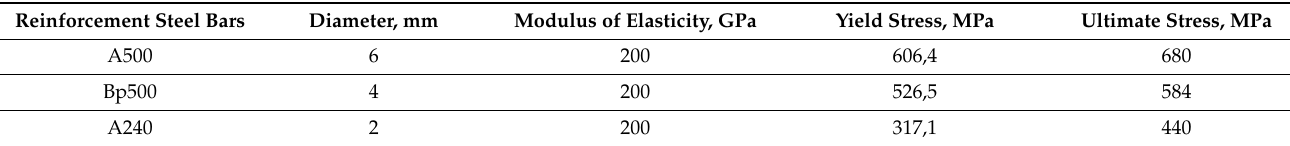
Table 2. Mechanical properties of steel reinforcement.